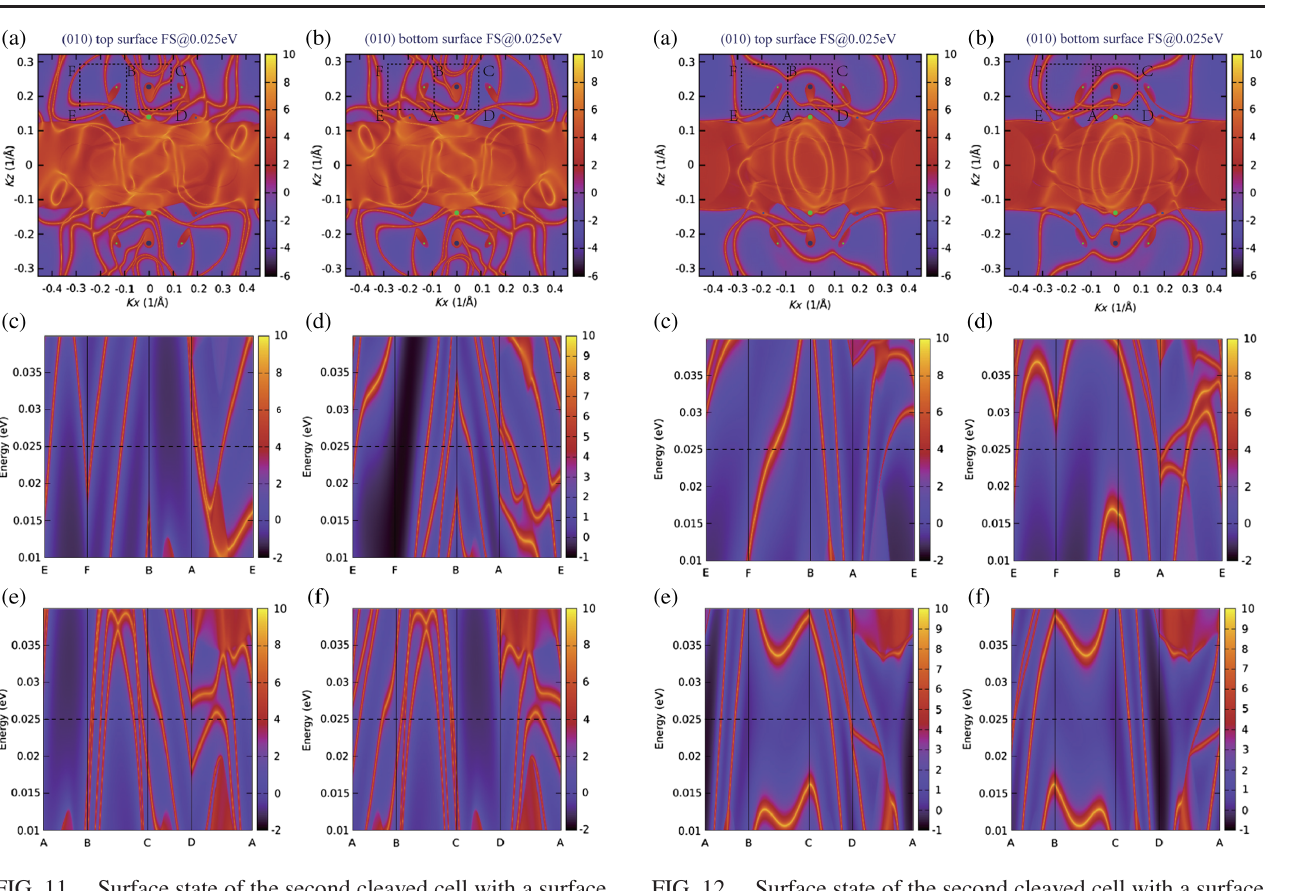
FIG. 11. Surface state of the second cleaved cell with a surface potential energy of 0.4 eV. (a,b) Fermi surface on the top and bottom (010) surfaces, respectively. The small dots represent the single projected WP, and the large dots represent two WPs with the same chirality projecting on top of each other. Panels (c) and (e) are the surface states of the top surface along the closed paths of E-F-B-A-E and A-B-C-D-A, respectively. Panels (d) and (f) are the same as (c) and (e) but for the bottom surface.